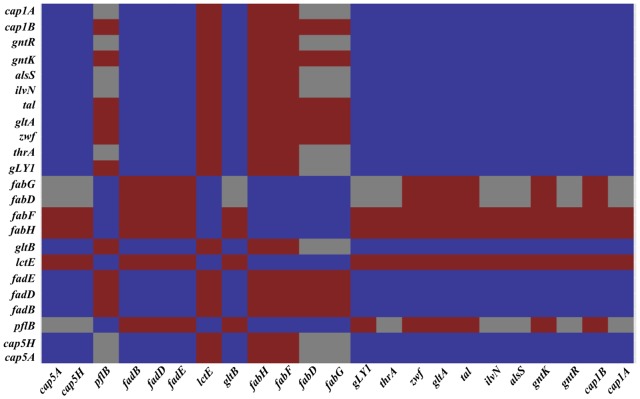
A correlation matrix of selected genes. Correlation of selected genes of classes differently expressed on S. aureus cells grown on galactose and under NO stress as determined by the T-Rex pipeline (de Jong et al., 2015). Genes with significant correlation are colored dark blue, genes showing good anti-correlation are colored red and uncorrelated genes are colored gray. SAUSA300_0152 (cap5A), SAUSA300_0159 (cap5H), SAUSA300_2597 (cap1B), SAUSA300_2598 (cap1A), SAUSA300_0220 (pflB), SAUSA300_0226-28 (fadBDE), SAUSA300_0235 (lctE), SAUSA300_0885-6 (fabHF), SAUSA300_1123-4 (fadDG), SAUSA300_1641 (gltA), SAUSA300_1454 (zwf), SAUSA300_1725 (taI), SAUSA300_2443 (gntK), SAUSA300_2166 (alsS), SAUSA300_2444 (gntR), SAUSA300_2008 (ilvN), SAUSA300_1225 (thrA), SAUSA300_1214 (gLY1), and SAUSA300_0445 (gltB).